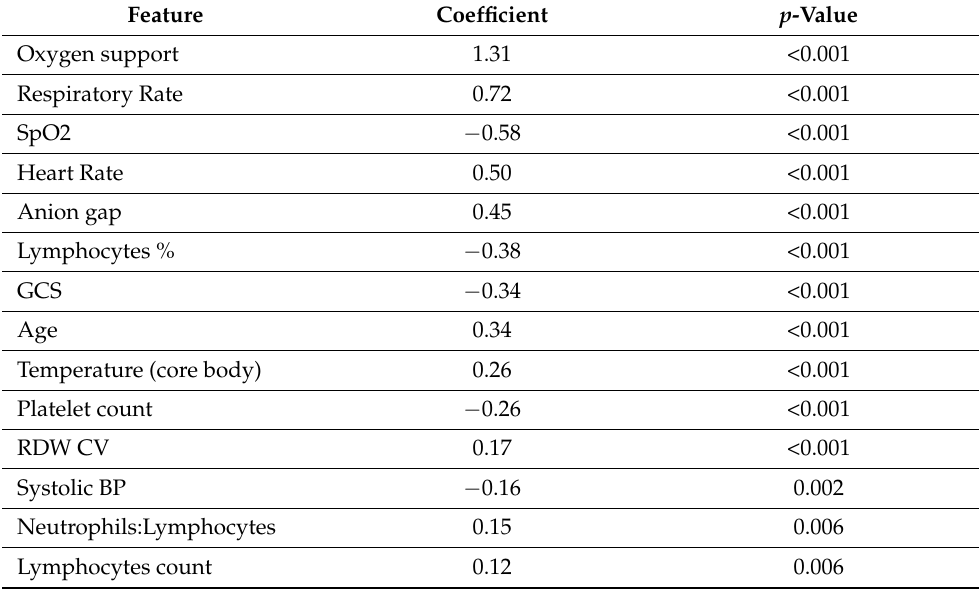
Table A6. Multivariate regression coefficients for comparison 3, 4 h prior to the